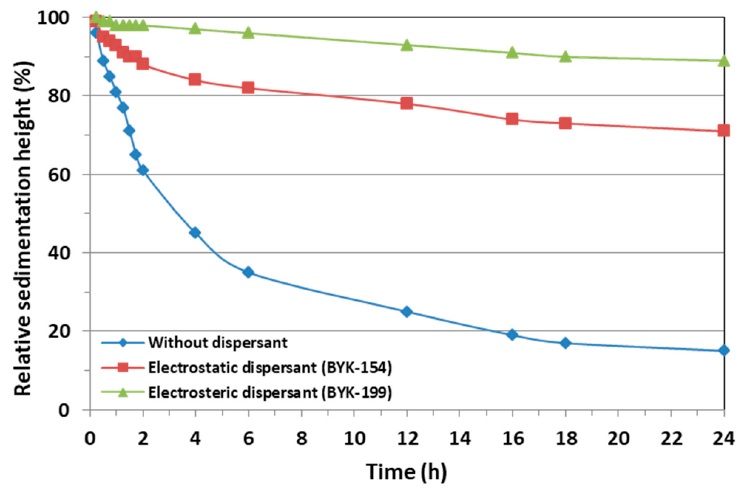
Figure 6. Relative sedimentation height of Y 5 O 4 F 7 suspensions with two types of dispersants and without dispersant as a function of time.